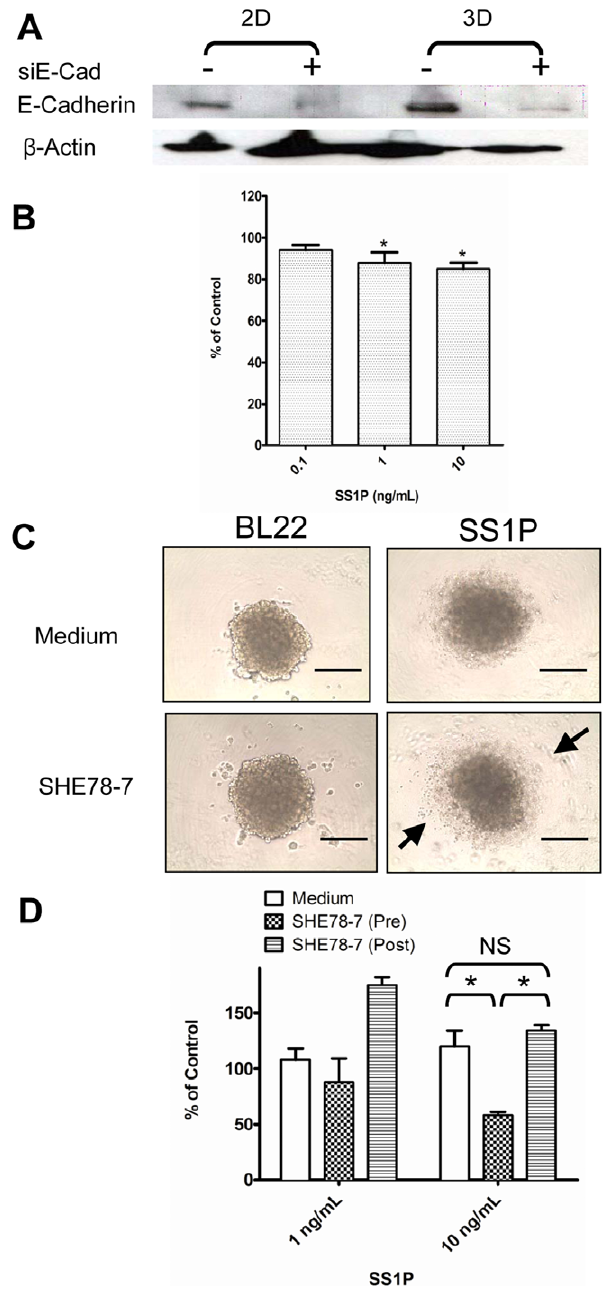
Figure 7. Sensitizing spheroids to immunotoxin therapy in vitro . A . Silencing E-Cadherin expression by siRNA. siE-Cad, E-Cadherin siRNA. 2D: monolayers; 3D: spheroids. B. Silencing E-Cadherin enhanced the anti-tumor activity of SS1P. Cell growth was assessed by incubation with WST-8 with values normalized (%) relative to the growth of the non-silencing siRNA (* p , 0.05). C and D . An anti- adhesive mAb targeting E-Cadherin (SHE78-7) enhanced the anti-tumor activity of SS1P when added before the formation of spheroids (Pre) (* p , 0.05), but not after (Post). Arrow, lysed cell debris. Scale bars, 400 m m. NS, not significant.